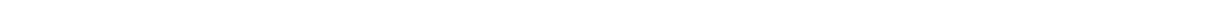
Figure 2 | Effect of GNPNAT1 knockdown in CRPC-like cells. shRNA knockdown (KD) of GNPNAT1 in 22Rv1 cells (22R-KD1/5) leads to ( a ) significant reduction in mRNA ( n ¼ 5, representative data), ( b ) loss of protein ( B 21kDa, n ¼ 5, representative immunoblot) and ( c ) significant decrease in product/ substrate ratio (4–5 biological replicates) for GNPNAT1 , compared with controls (22R-NT). Similarly, KD of GNPNAT1 in LNCaP-ABL cells (L-KD1/5) leads to ( d ) significant reduction in mRNA ( n ¼ 3, representative data), ( e ) loss of protein ( n ¼ 3, representative immunoblot) and ( f ) significant decrease in product/substrate ratio (5 biological replicates) for GNPNAT1 , compared with controls (L-NT). ( g ) GNPNAT1 KD in 22Rv1 cells significantly